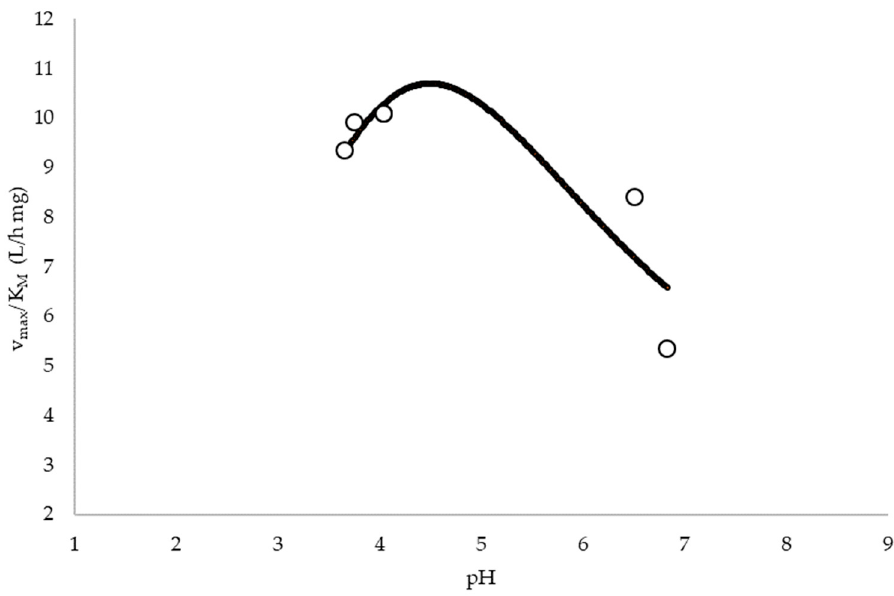
Figure 9. Effect of pH on the kinetics of COD degradation at TOC 0 = 1400 mg/L and T = 30 ◦